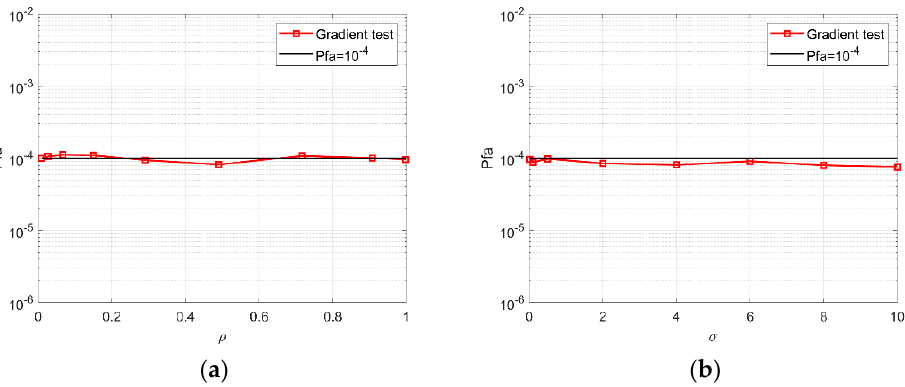
Figure 1. CFAR property analysis for N = 16, K = 2 N : ( a ) P fa versus ρ of gradient test; ( b ) P fa versus σ of gradient test.